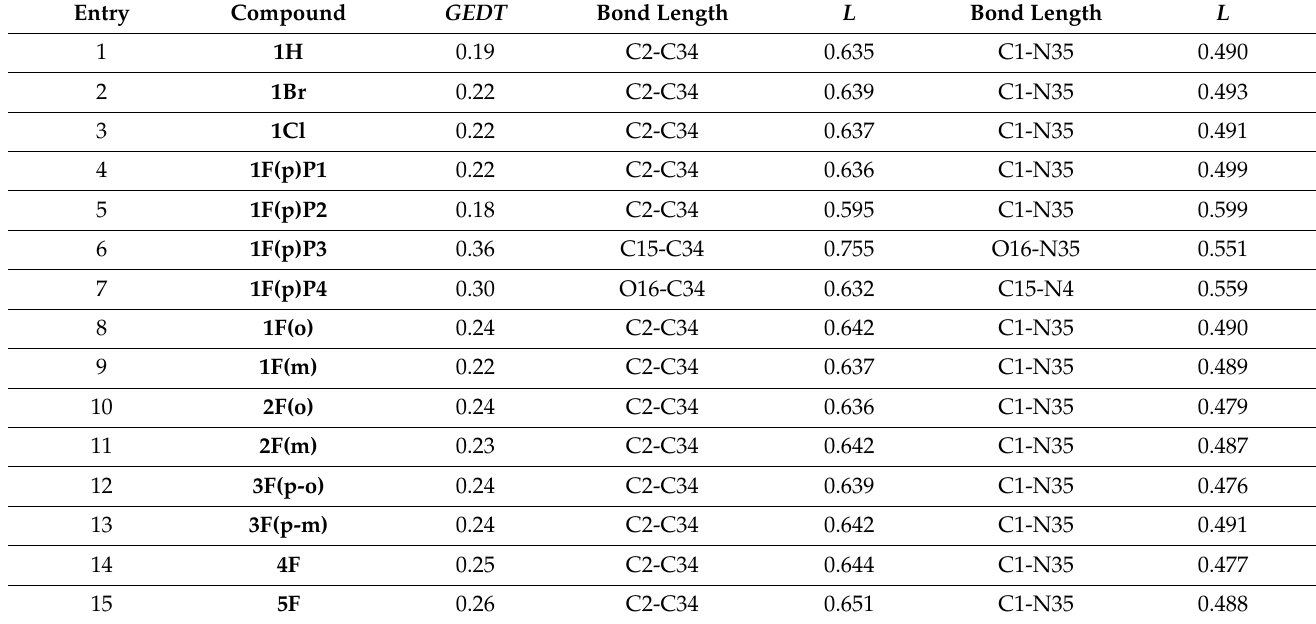
Table 4. Computed GEDT ( e ) and L (Å) of the new formed σ bonds for all calculated transition